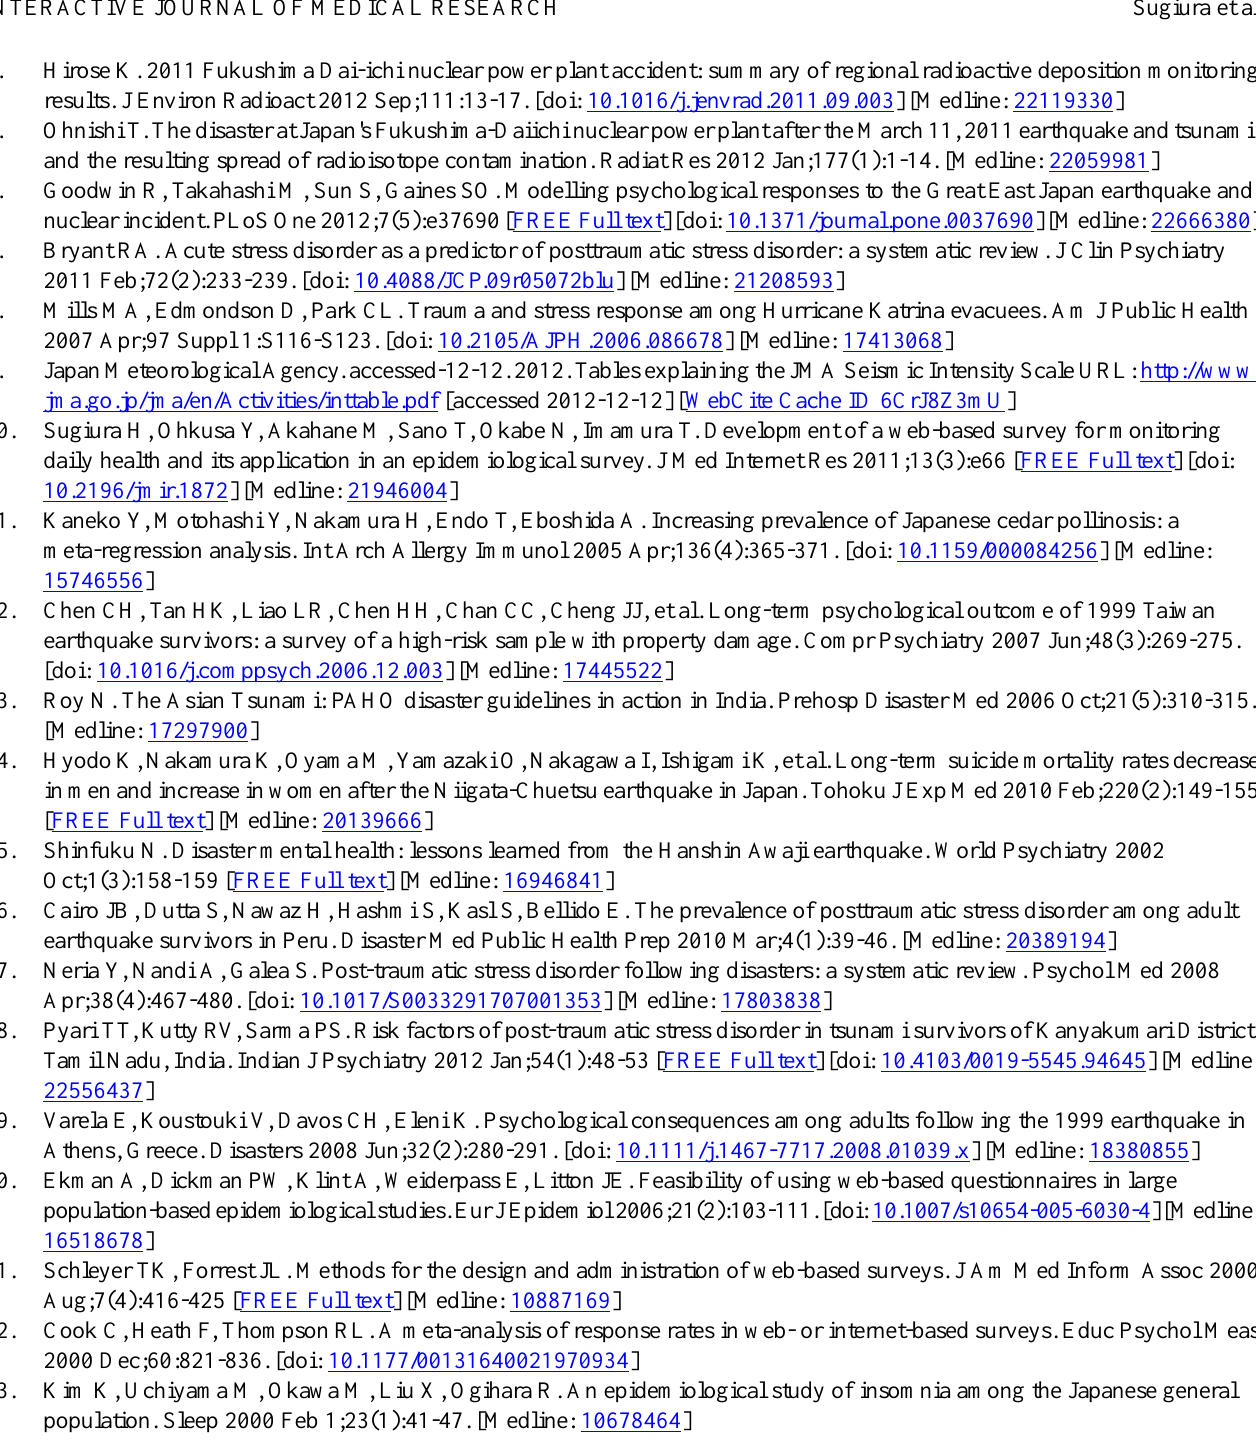
Abbreviations ASD: acute stress disorder CO-OP: Consumers’ Co-operative Union JMA: Japan Meteorological Agency PTSD: post-traumatic stress